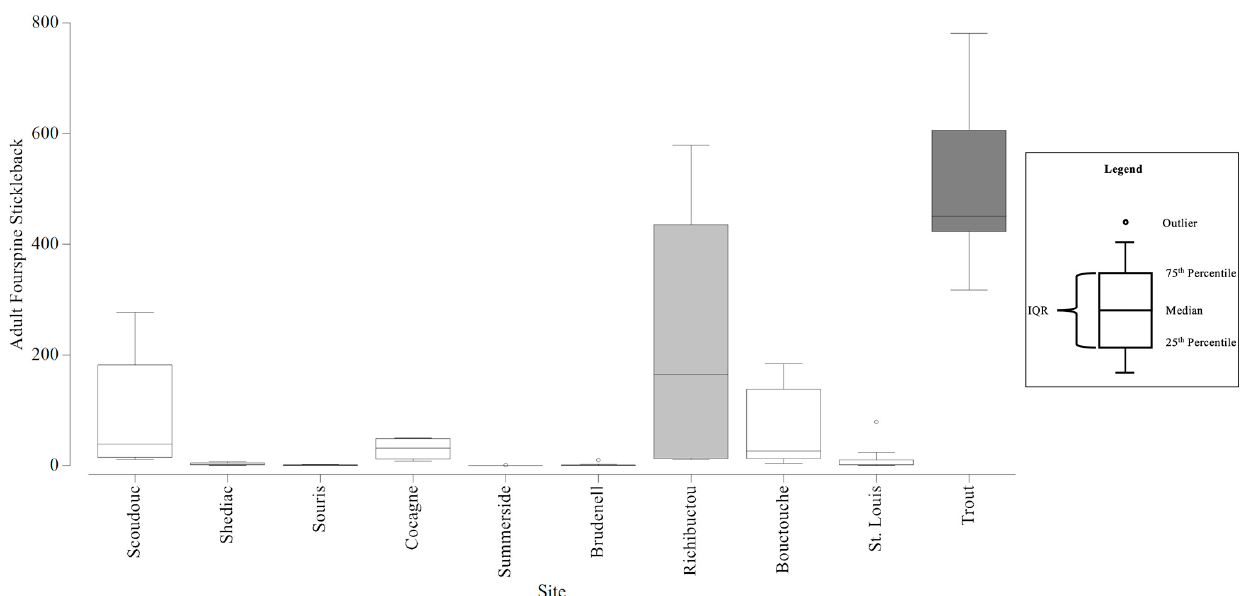
Figure 6. Boxplots generated using the adult Fourspine Stickleback counts collected from the Community Aquatic Monitoring Program (CAMP) stations at each estuary. The box shaded dark grey identifies the adult Fourspine Stickleback abundances that are significantly different from the abundances at the other estuaries (except the light grey box), and the difference is large enough to be detected, with confidence, in consideration of the precision of the CAMP sampling design. Circles above the boxplots (i.e., outliers) are outside 1.5 times the interquartile range (IQR).